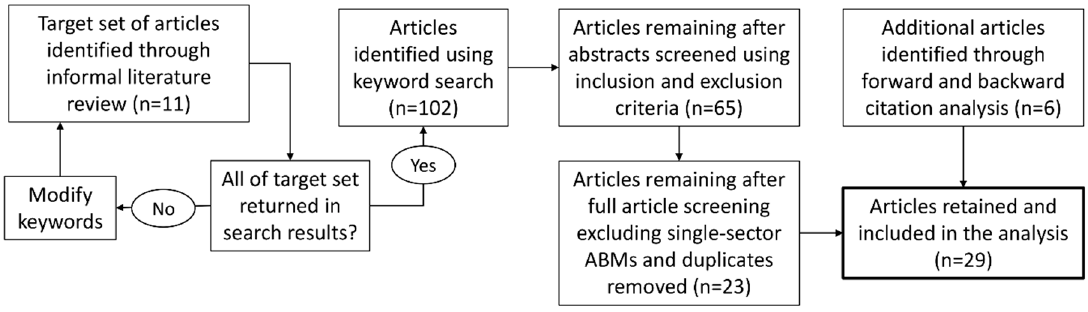
Figure 1. Search and screening process to assemble the article collection for review.